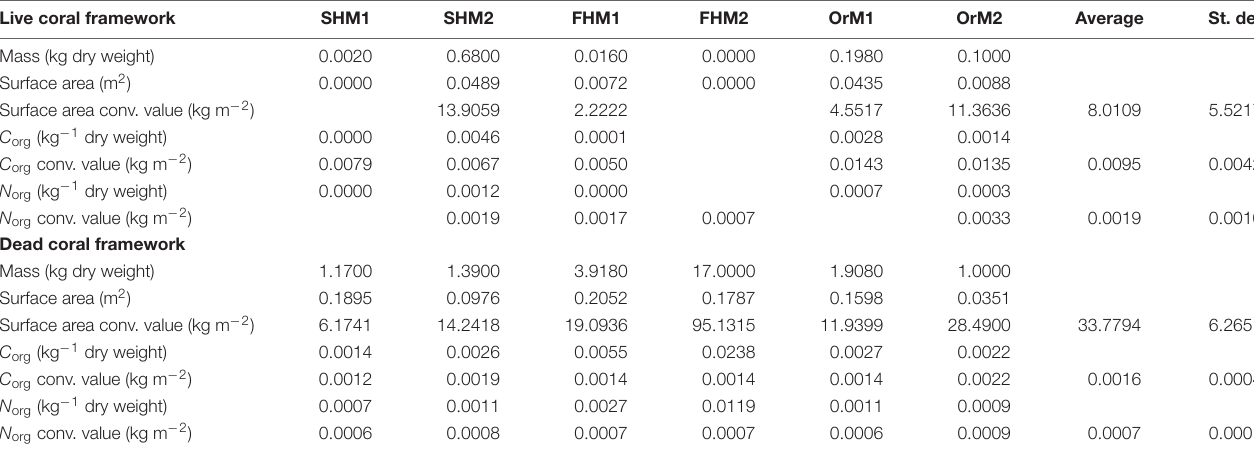
TABLE 3 | Table showing the calculation of the average conversion values and standard deviations used in step 4 and step 5. Live coral